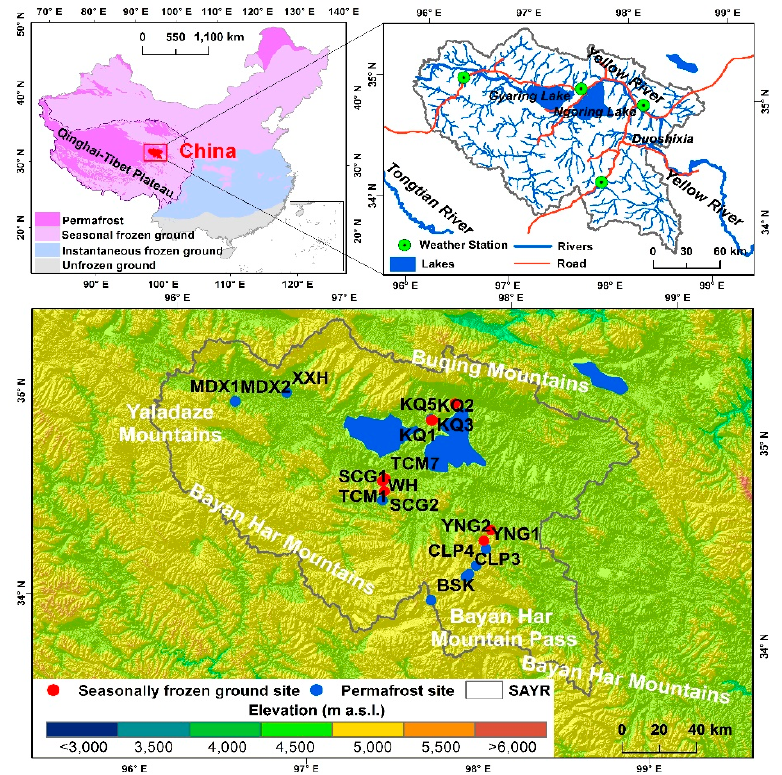
Figure 1. Study area and site locations in the Headwater Area of the Yellow River on the northeastern Qinghai-Tibet Plateau, Southwest China. All the sites are named based on name of the village nearby or the topography.